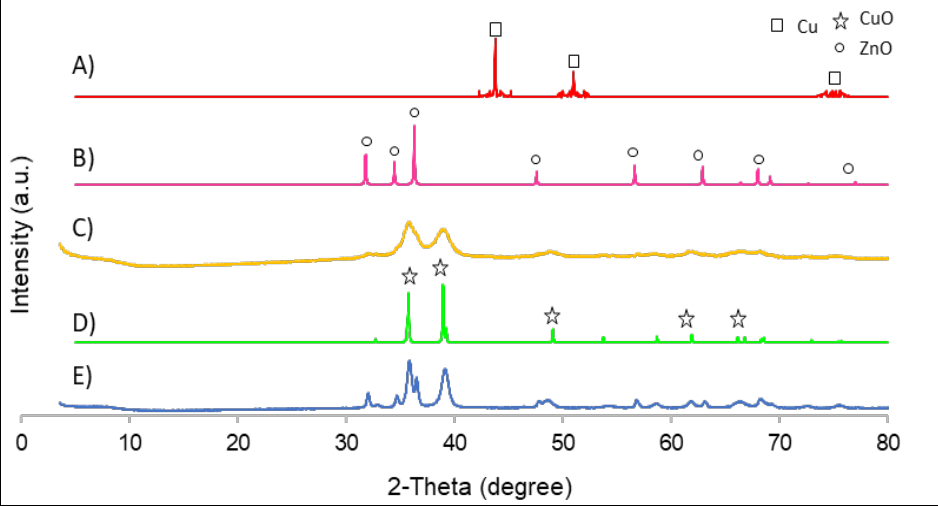
Figure 2. XRD patterns of all catalysts: ( A ) Cu nanoparticle simulation; ( B ) ZnO nanoparticle simulation; ( C ) Cu/ZnO nanoparticles; ( D ) CuO nanoparticle simulation; ( E ) CuO/ZnO nanoparticles.